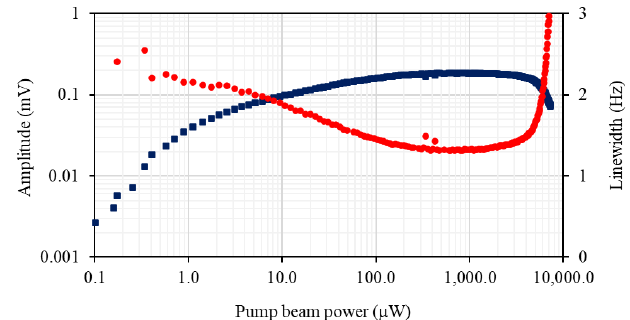
Figure 3. Amplitude (blue squares) and linewidth (red dots) of the rf spectral profile as a function of pump beam power recorded at cell temperature of 22 ◦ C.